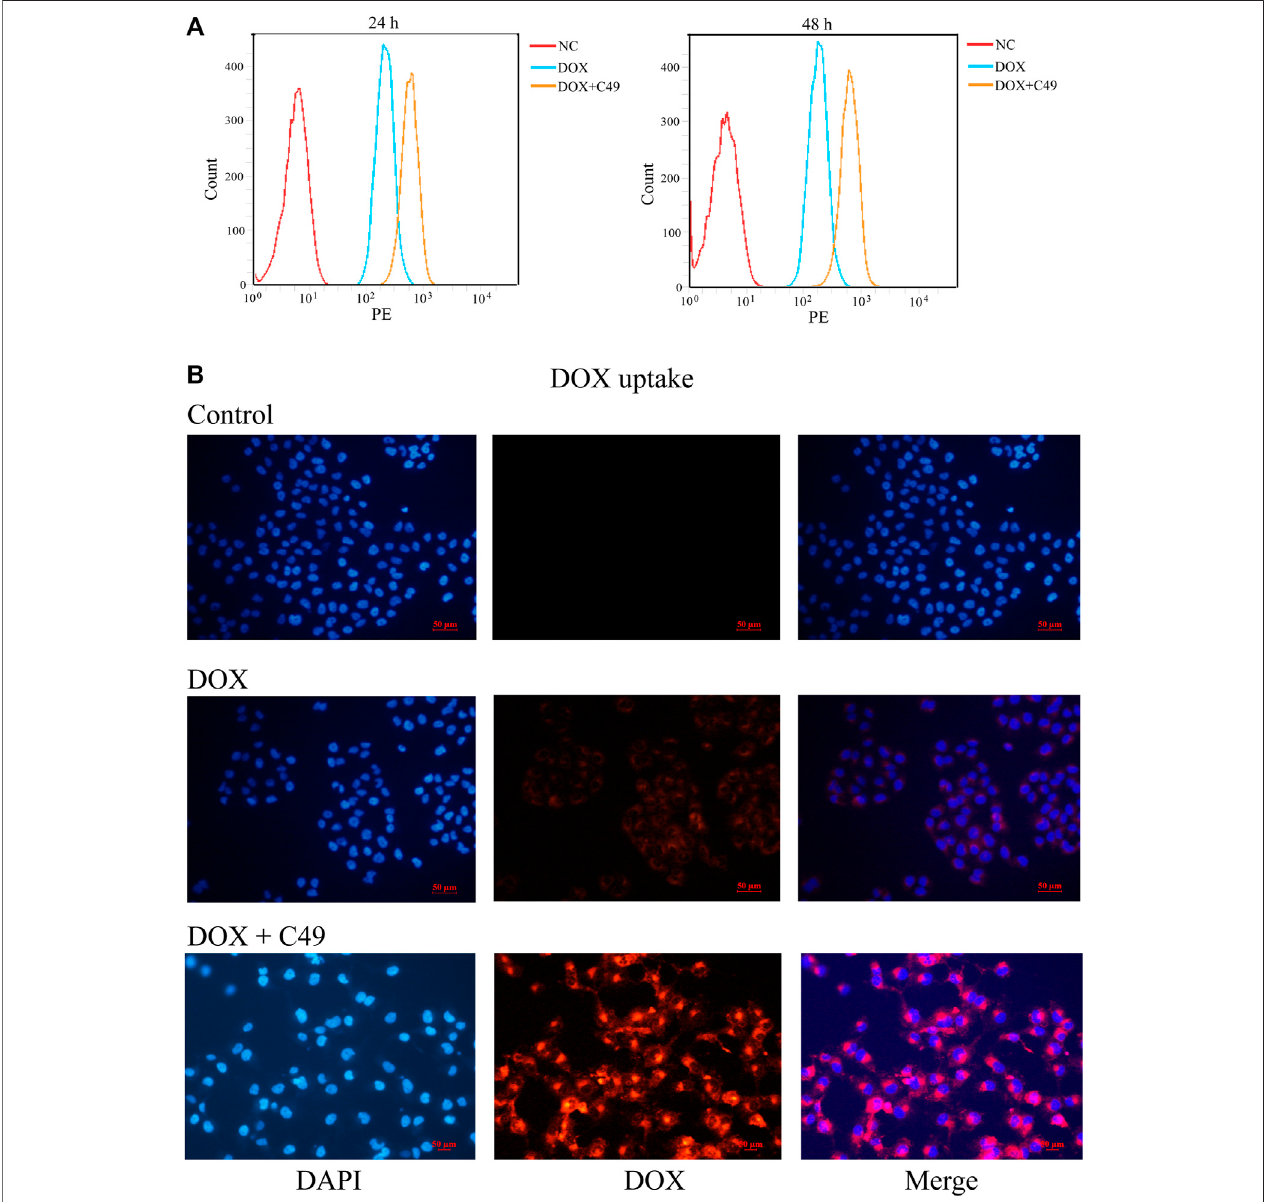
FIGURE 4 | C49 combined with DOX increased intracellular concentration of DOX in MCF-7/DOX cells. (A) Cells were treated with DOX (8 μ M) and C49 (12.5 μ M) for24or48 h, and DOXaccumulationinthecellswereanalyzed using fl owcytometry. (B) CellsweretreatedwithDOX(8 μ M) and/or C49(12.5 μ M) for48 hand stained with DAPI. DAPI: blue fl uorescence, DOX: red fl